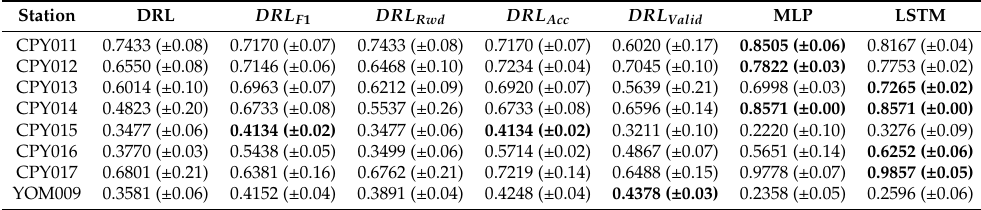
Figure 6. A critical difference diagram of each model. Table 4. The mean F1-scores and standard deviation of all DRL, MLP, and LSTM models when testing with the dataset from different stations (the best F1-score of each row is shown in bold).